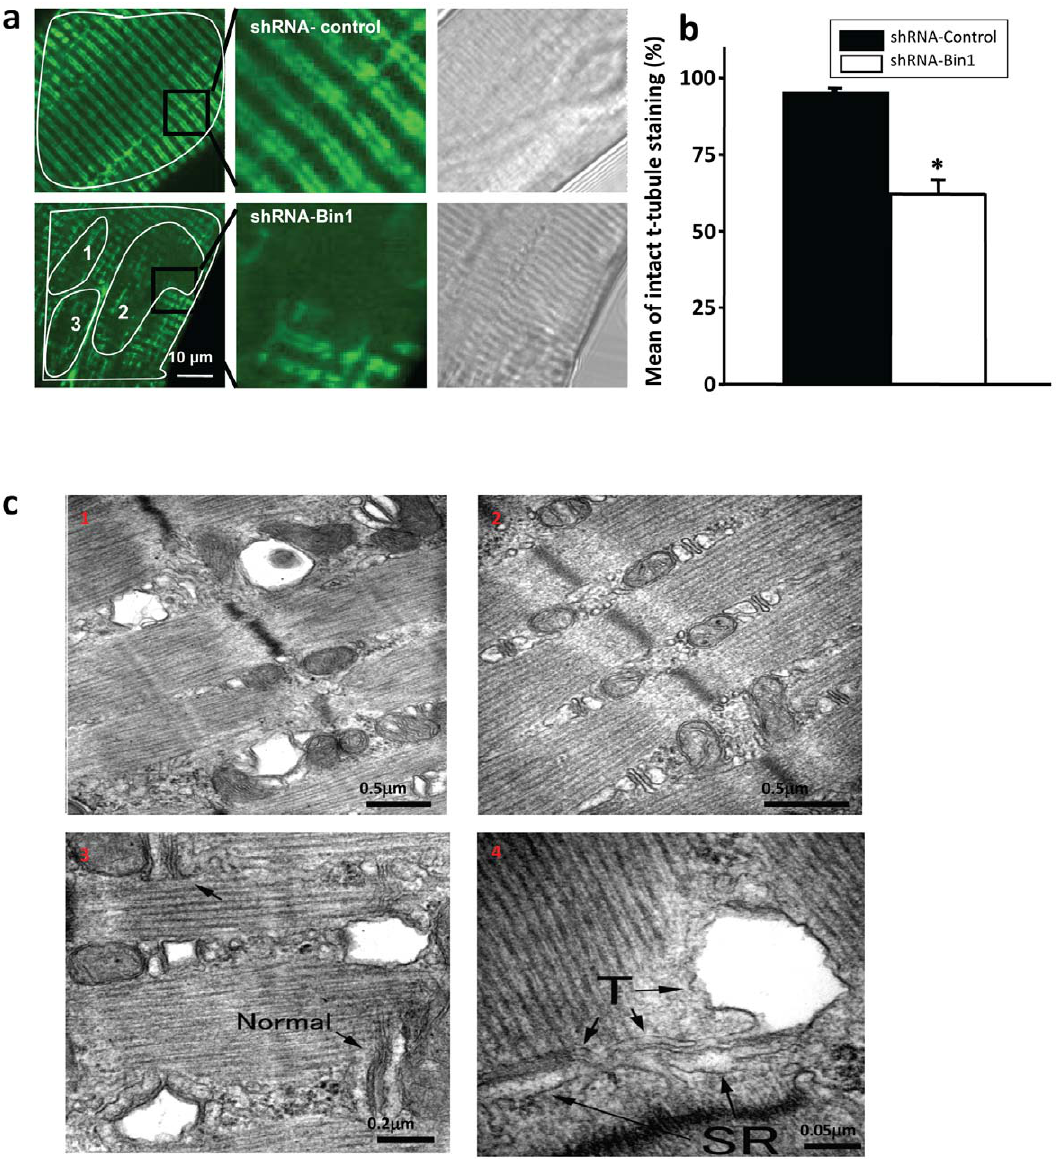
Figure 2. Disrupted t-tubule structure in adult shRNA-Bin1 muscle. (a, left ) Individually isolated FDB muscle fiber that was electroporated with either shRNA-control or shRNA-Bin1 plasmid was stained with 100 nM DiOC5 that labeled intact t-tubule membrane structure. shRNA-Bin1 fibers exhibited loss or diffused of t-tubule staining in shRNA-Bin1 muscle fibers (n=13), that otherwise were not observed in the shRNA-control fibers (n=13). Enlarged images showed that bifurcated t-tubule doublets characteristics were missing in the shRNA-Bin1 fibers ( middle ). Brightfield images (right ) of cross-striated pattern in both shRNA-control and shRNA-Bin1 indicated healthy muscle fibers were chosen for DiOC5 staining. Several regions of interests (ROI) were drawn on the areas of the fibers that displayed blank DiOC5 staining (numerically labeled small ROIs) and then the total affected area in each fiber was divided by the total surface area of the fiber (large ROI drawn covering the surface area of the fiber). Black box represents the enlarged area showing the bifurcated t-tubule staining. (b)Quantification of missing/diffused staining observed in shRNA-Bin1 (blank square) when compared to shRNA-control (filled square) fibers. (c) EM analysis performed on the trimmed electroporated FDB muscle bundle showed that 25–30% of cells in the FDB muscle bundle transfected with shRNA-Bin1 displayed vacuolation/swollen t-tubule structure (c 1 ), whereas the remainder , 70% exhibited normal t-tubule structure as seen in shRNA-control FDB muscle bundle (c 2 ). (c 3,4 ) Enlargement of the cells showing swollen t-tubule structure from the shRNA-Bin FDB muscle bundle. Arrows in (c 3 ) indicate normal t-tubules while in (c 4 ) the arrows indicate enlarged/ vacuolated t-tubule structures in shRNA-Bin1 fibers. n=56 for shRNA-control cells, and n=63 for shRNA-Bin1 cells.